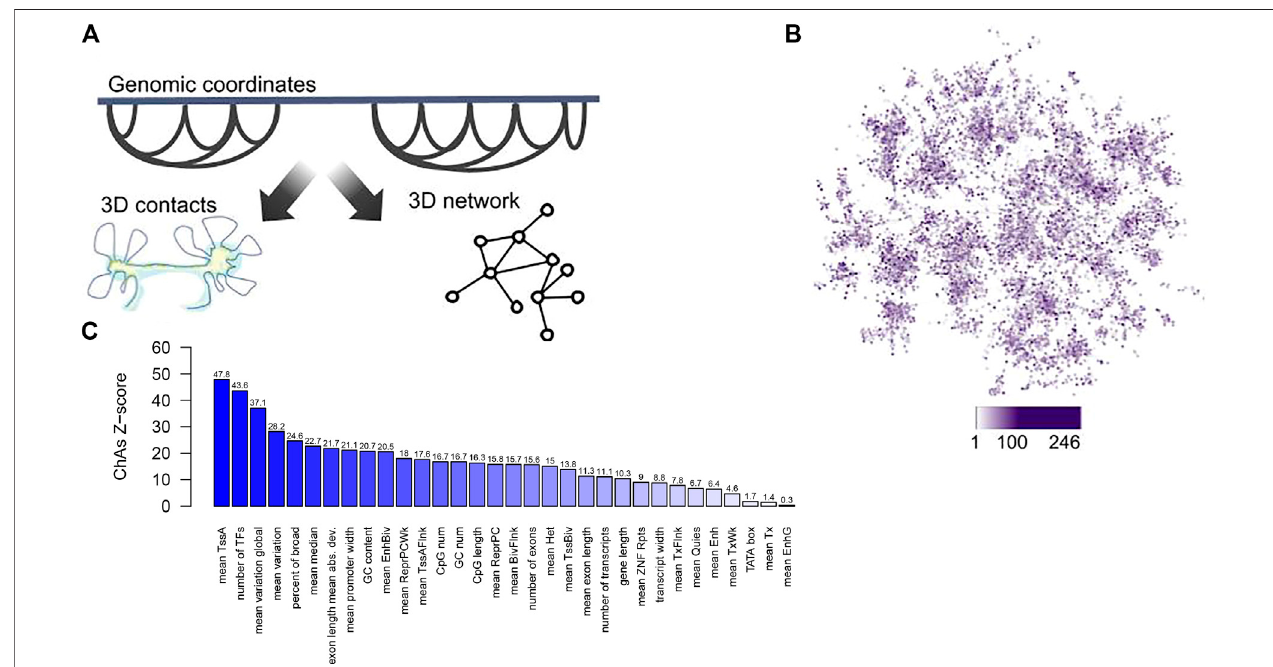
FIGURE 1 | A chromatin assortativity analysis performed on the chromatin network shows preferential interactions of genes that have similar promoter characteristics. (A) Schematic describing the chromatin network approach in which nodes are chromatin fragments and edges describe experimentally identi fi ed 3D contactsbetweenchromatinfragments, (B) ProjectionofpromoterwidthfromSigalovaetal.(2020)averagedacrossmanytissuesontothecombinedPromoterCapture Hi-C networkforhaematopoieticcells(Javierreet al.,2016).Inthisnetworknodes aregenepromotersandnode colourrepresentsvaluesof “ promoterwidth ” with increasing width shown as darker purple. (C) Chromatin assortativity analysis here measures whether promoters with similar values of the promoter features detailed in Sigalova et al. interact preferentially in the network from (A) . For each feature a ChAs value is calculated and the values obtained in 100 randomized networks is used to estimate a Z-score, shown on the barplot for each feature. The ChAs calculation is performed using distance preserving randomizations with the ChAseR package (Madrid-Mencía et al., 2020). High values of the Z-score denote preferential 3D distal interactions of promoters with similar values for these